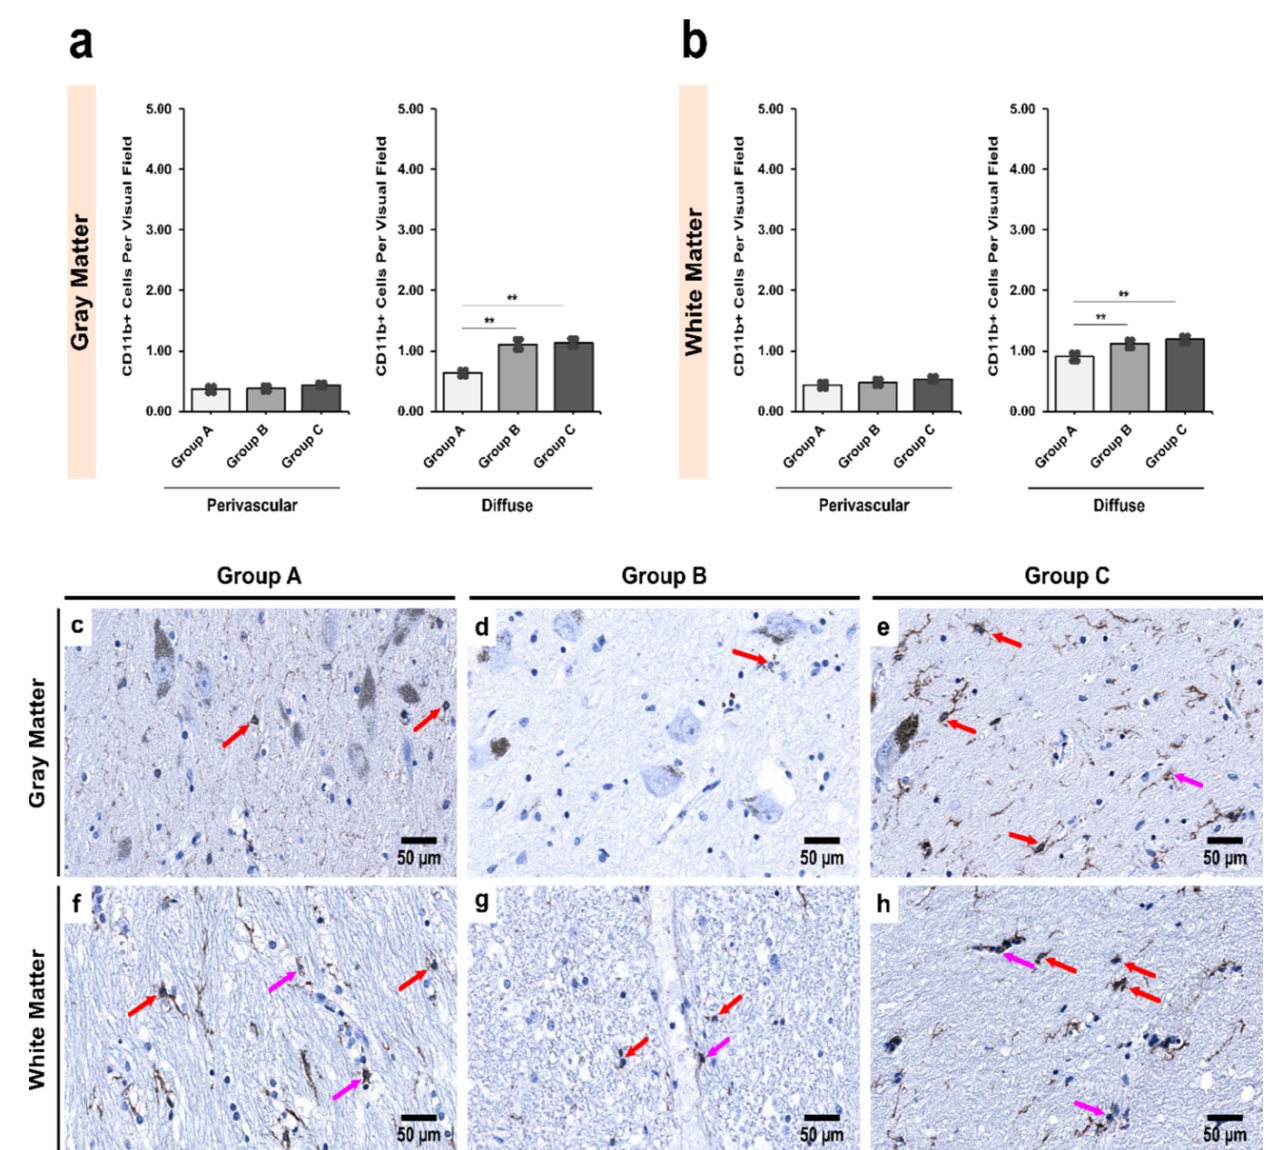
Figure 5. Intergroup analysis of CD11b+ cells per visual field in Pars Compacta (SNpc) for the three studied groups in both ( a ) gray and ( b ) white matter. The analysis was done for both perivascular and diffuse locations. The bar plots indicate the average number of CD11b+ cells ± S.E. (Standard Error) seen per visual field. ** indicates a significant difference between the groups ( p < 0.05 with Bonferroni correction is considered significant). Distribution of CD11b+ cells per visual field in ( c , f ) Group A (controls); ( d , g ) Group B (age-matched alcoholics) and ( e , h ) Group C (non-age-matched alcoholics). Pink arrows indicate perivascular CD11b+ cells while red arrows indicate diffuse CD11b+ cells. Original magnification, 400 × . Scale bars, 50 µ